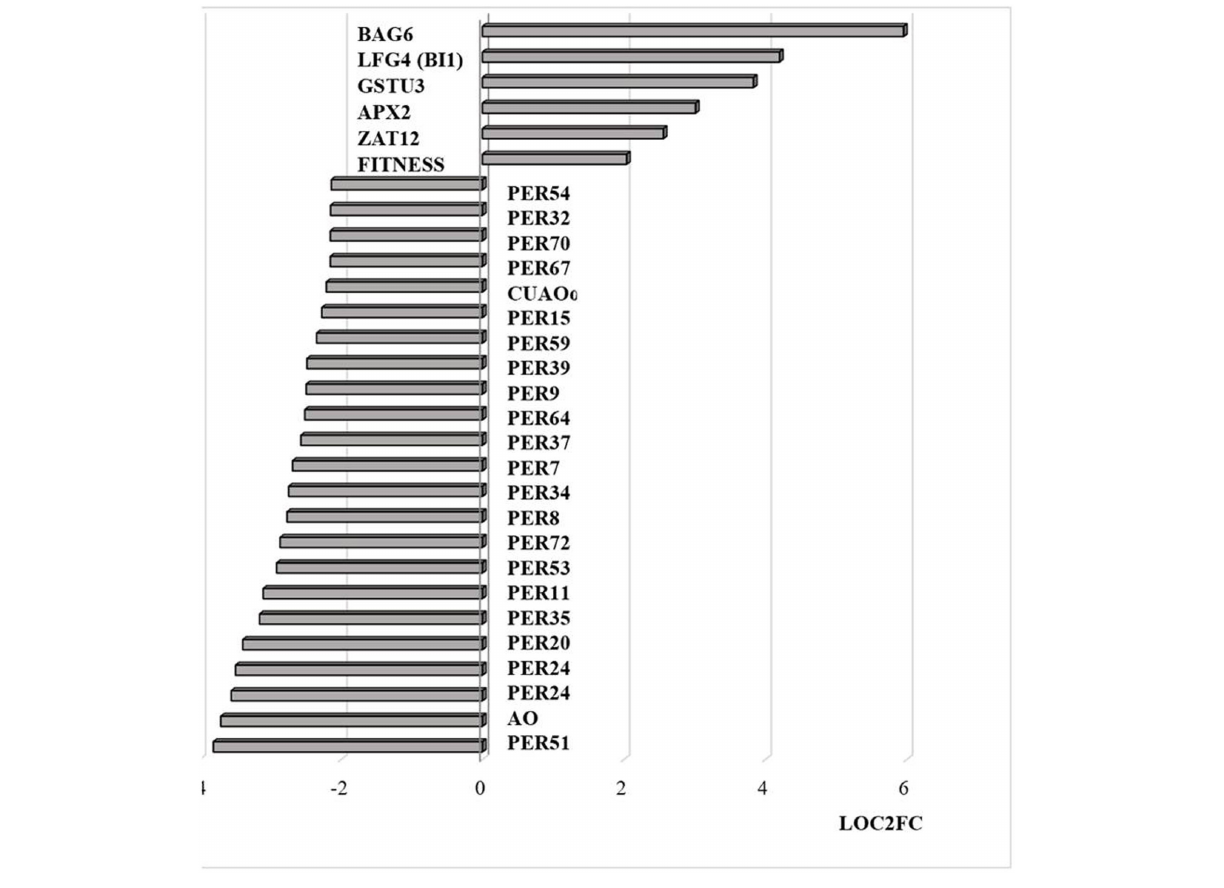
FIGURE 8 | Transcripts encoding proteins associated with cell death and peroxidases that are differentially regulated by heat stress and targeted to the nucleus. The abundance is expressed as relative expression of (log2) fold change (LOG2FC) with an FPKM > 1 and FDR-corrected p- value of 0.05 or less. PER54 (AT5G06730), PER32 (AT3G32980), PER70 (AT5G64110), PER67 (AT5G58390), PER15 (AT2G18150), PER59 (AT5G19890), PER39 (AT4G11290), PER64 (AT5G42180), PER37 (AT4G08770), PER34 (AT3G49120), PER8 (AT1G34510), PER72 (AT5G66390), PER53 (AT5G06720), PER11 (AT1G68850), PER35 (AT3G49960), PER20 (AT2G35380), PER24 (AT2G39040), PER24 (AT2G39040), AO (AT5G21100), PER51 (AT4G37530), FITNESS (AT1G07050), ZAT12 (AT5G59820), APX2 (AT3G09640), GSTU3 (AT2G29470), LFG4(BI1) (AT1G03070), BAG6 (AT2G46240), PER7 (AT1G30870), CUAO α 2 (AT1G31690), PER9